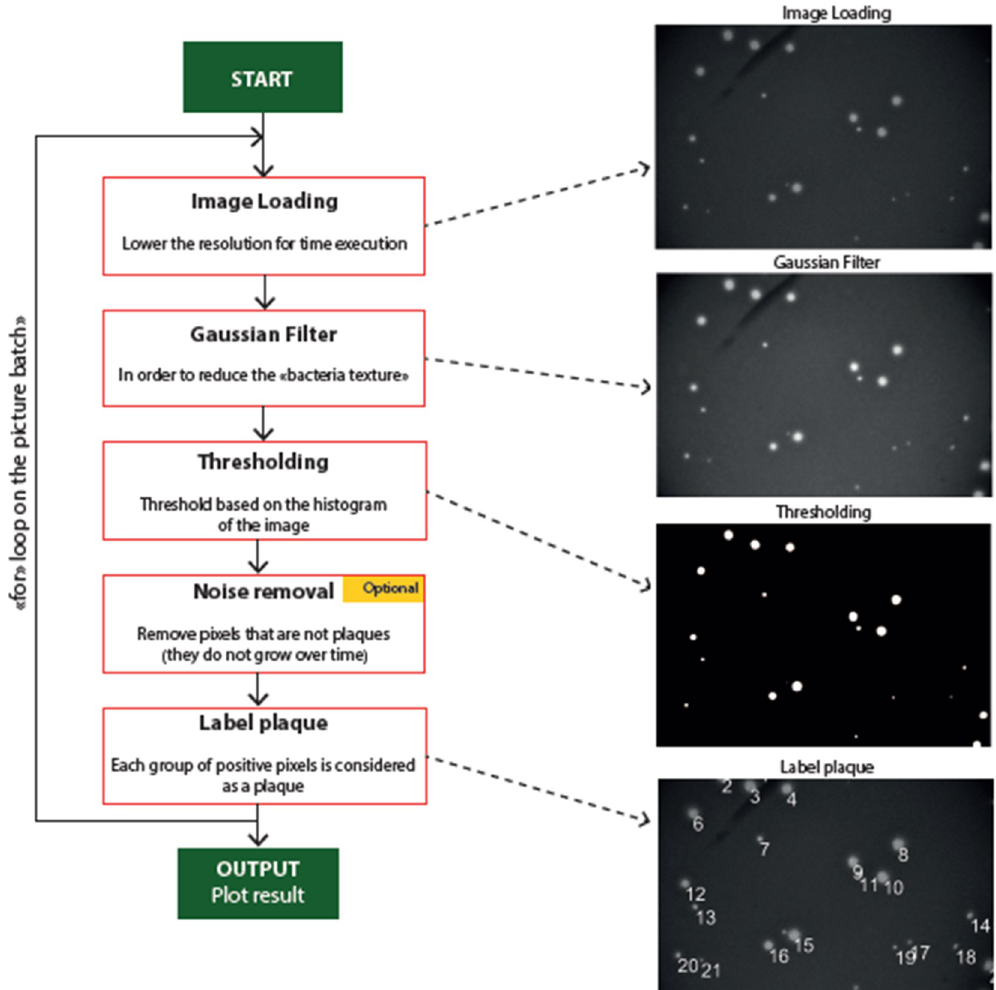
Fig 2. Algorithm structure to count phage